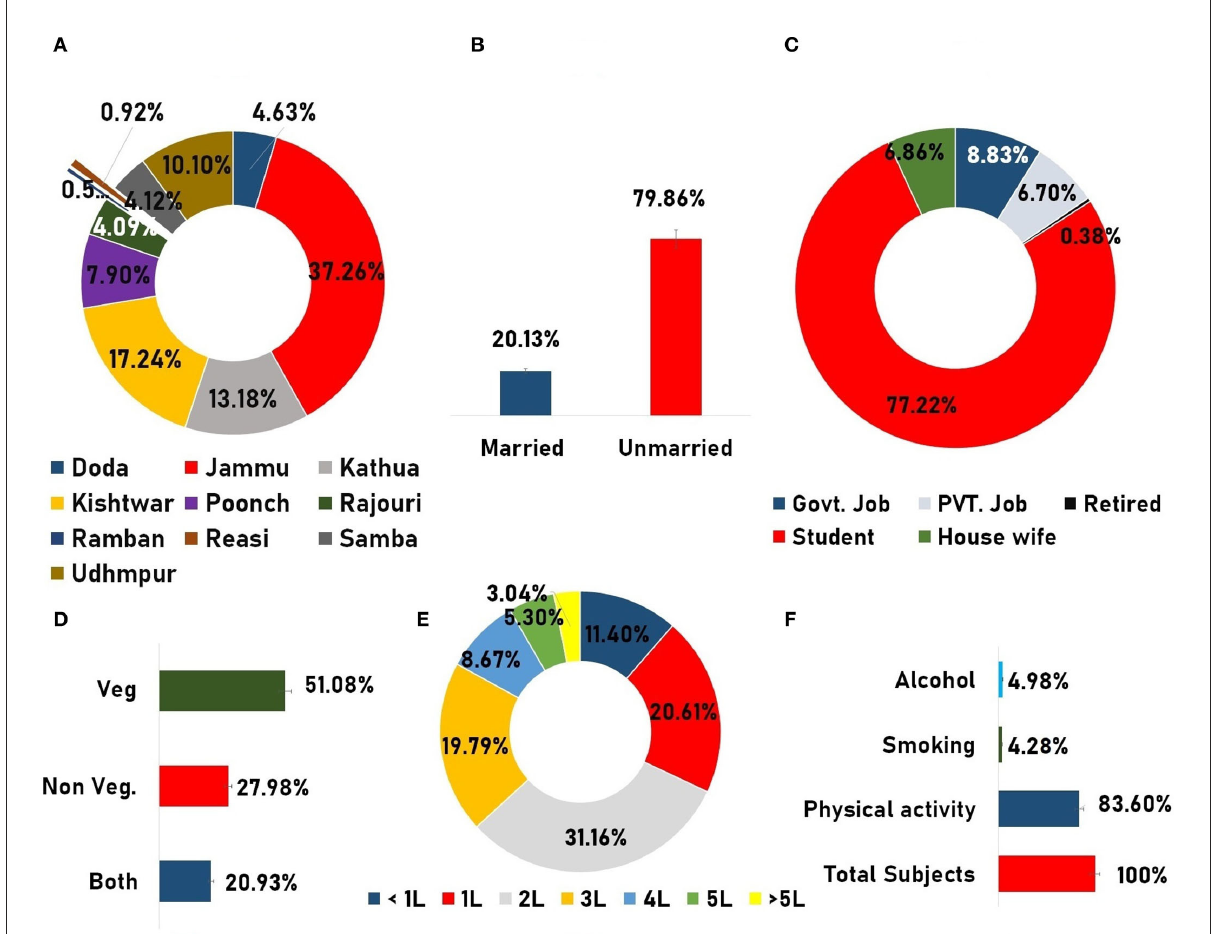
FIGURE3 Demographic infographics. (A) Doughnut graph representing the total subject inclusion from different parts of the Jammu division. (B) Column graph showing the marital status. (C) Doughnut graph representing the occupation status of the participants. (D) Dietary habit of the participants. (E) Doughnut diagram showing the frequency of the total water intake in liters by the participants. (F) Presentation of frequency of different data variables such as “physical activities,” “smoking,” andand “alcohol